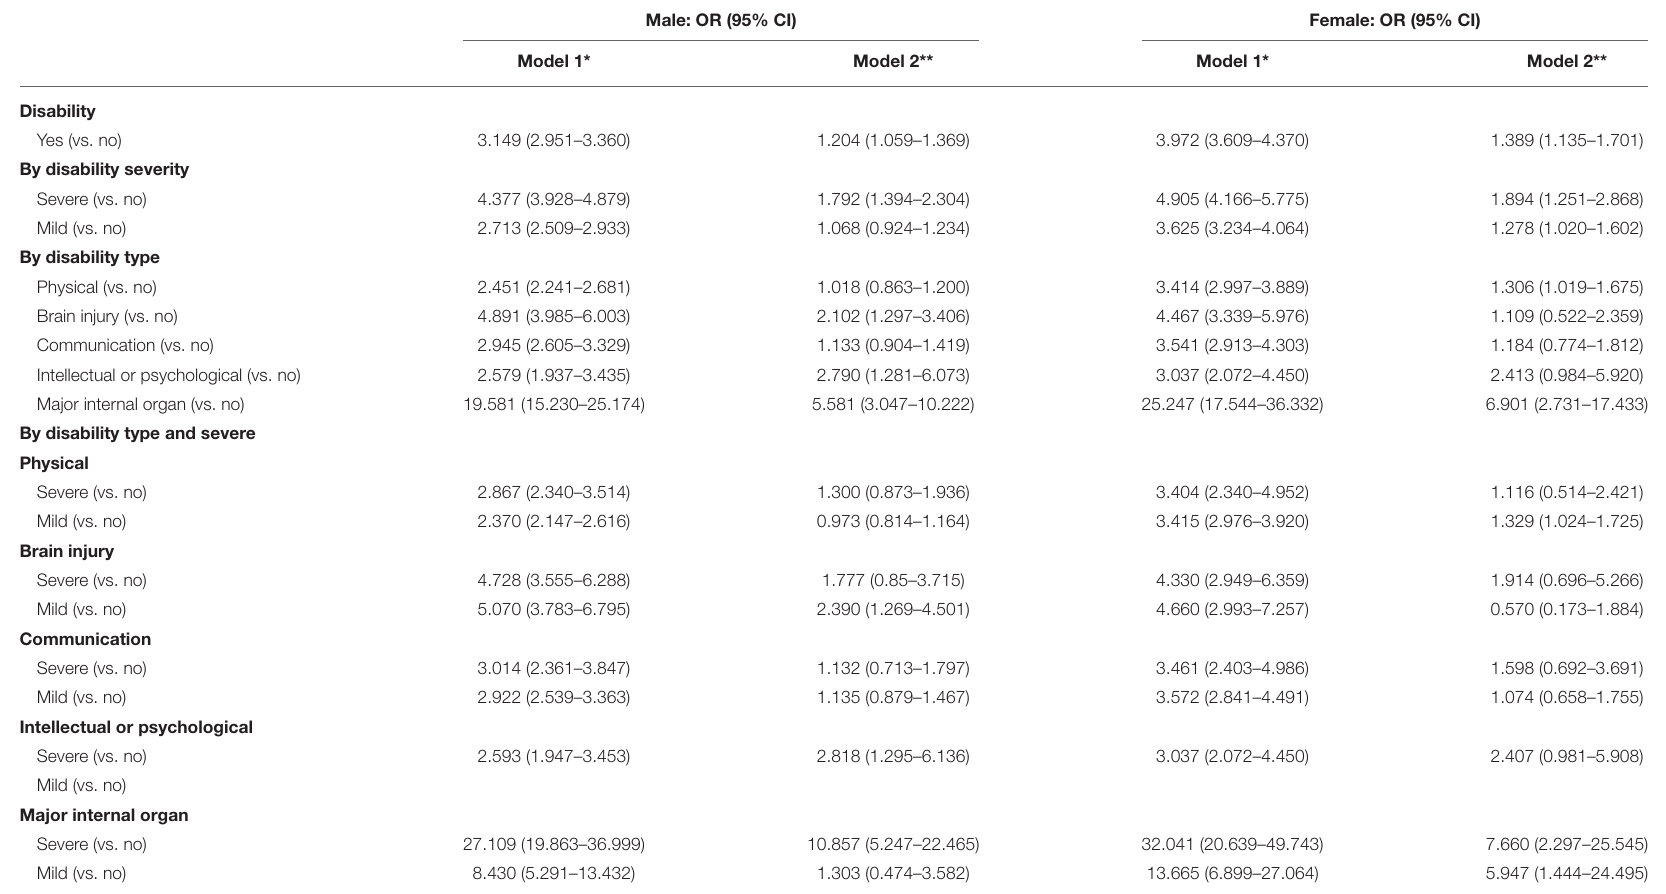
TABLE 2 | Factors associated with complicated appendicitis during